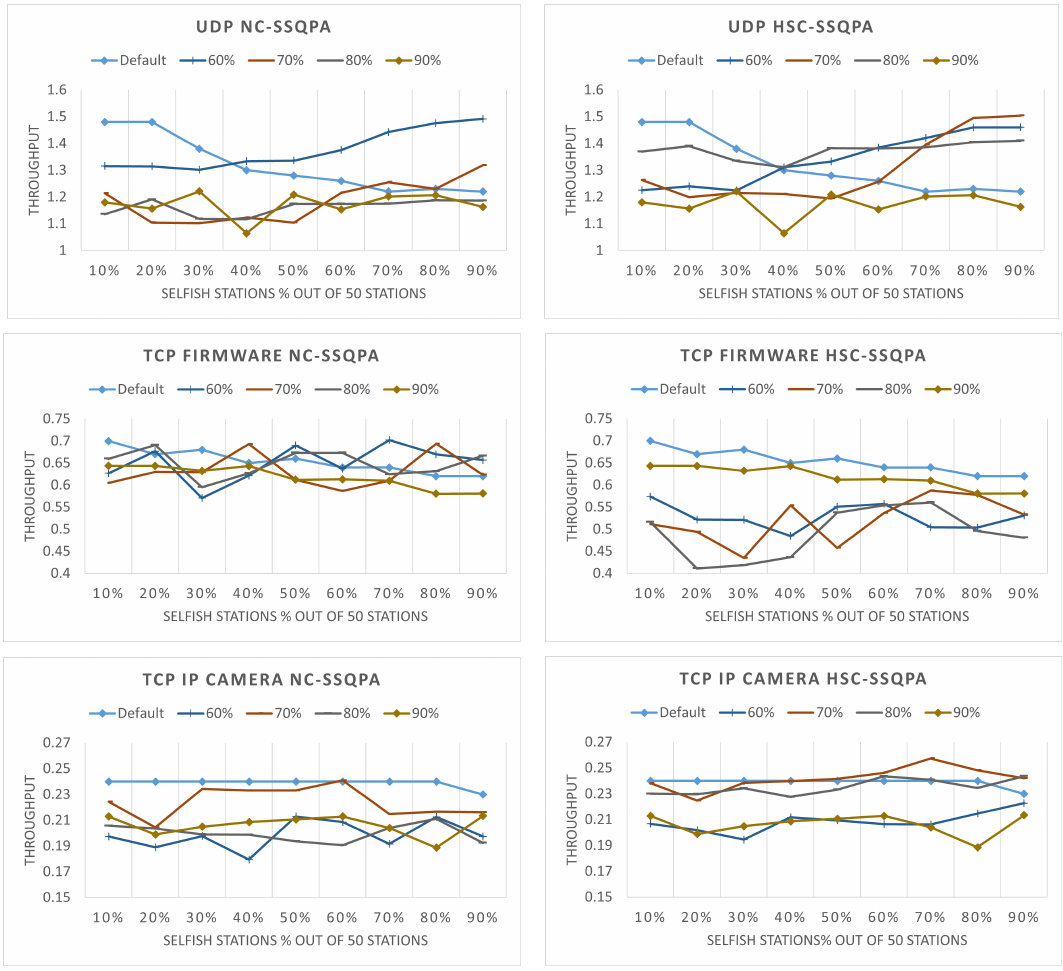
Figure 16. Network throughput (in Mbps) for different percentage of detected stations: ( left ) NC- SSQPA, ( right )